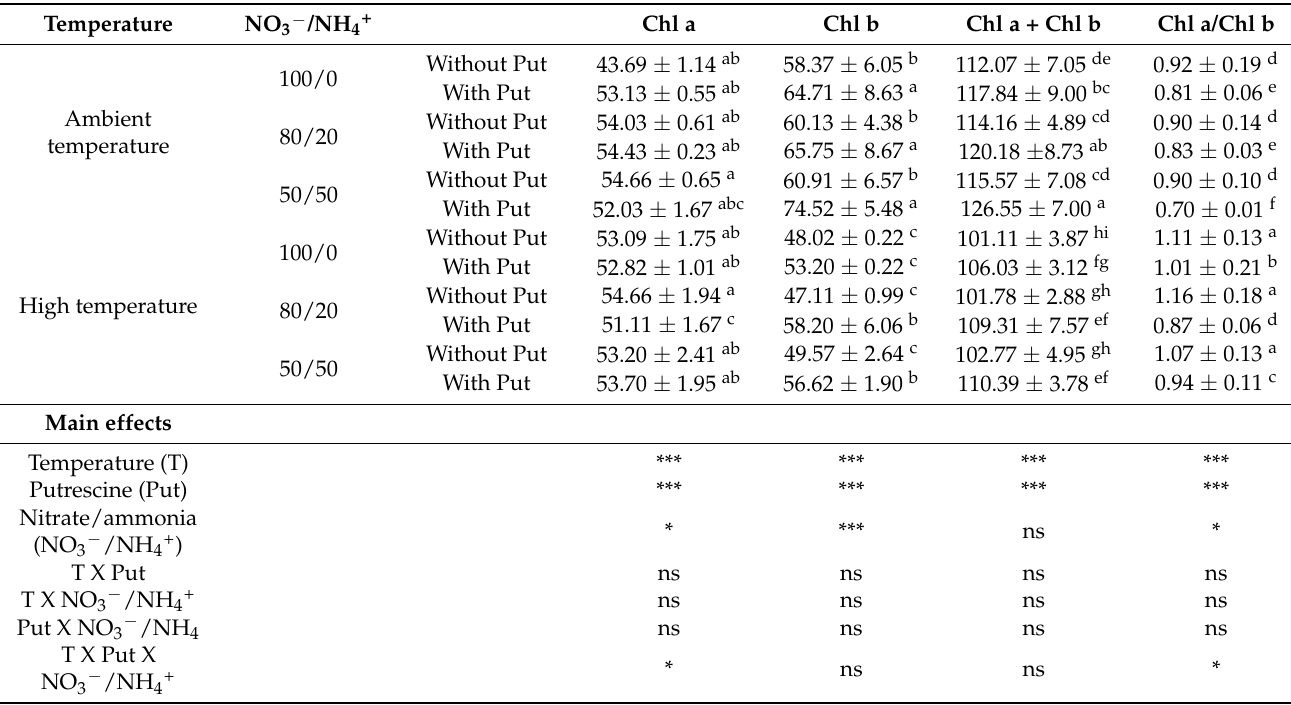
Different small letters within a column indicate significant differences among different treatments of putrescine treatments with different NO 3 − /NH 4+ ratio and temperatures ( p = 0.05. Tukey test). n = 5, ± S.E. Analysis of variance: ns. not significant; * p ≤ 0.05; *** p ≤